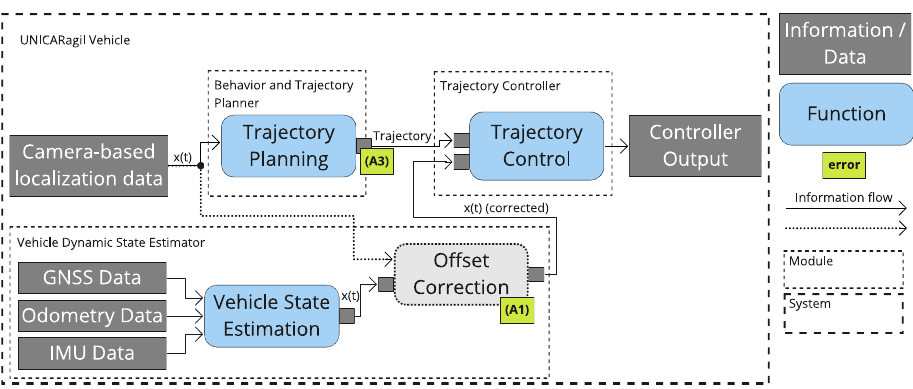
Figure 4. Simplified functional architecture of the module’s behavior and trajectory planner , trajectory controller and vehicle state estimator together with the added function offset correction reproduced with the permission from Homolla et al. [24]. Information/data flow, functions and modules of the UNICAR agil vehicle are not completely illustrated. Green boxes show the location of the experienced errors.